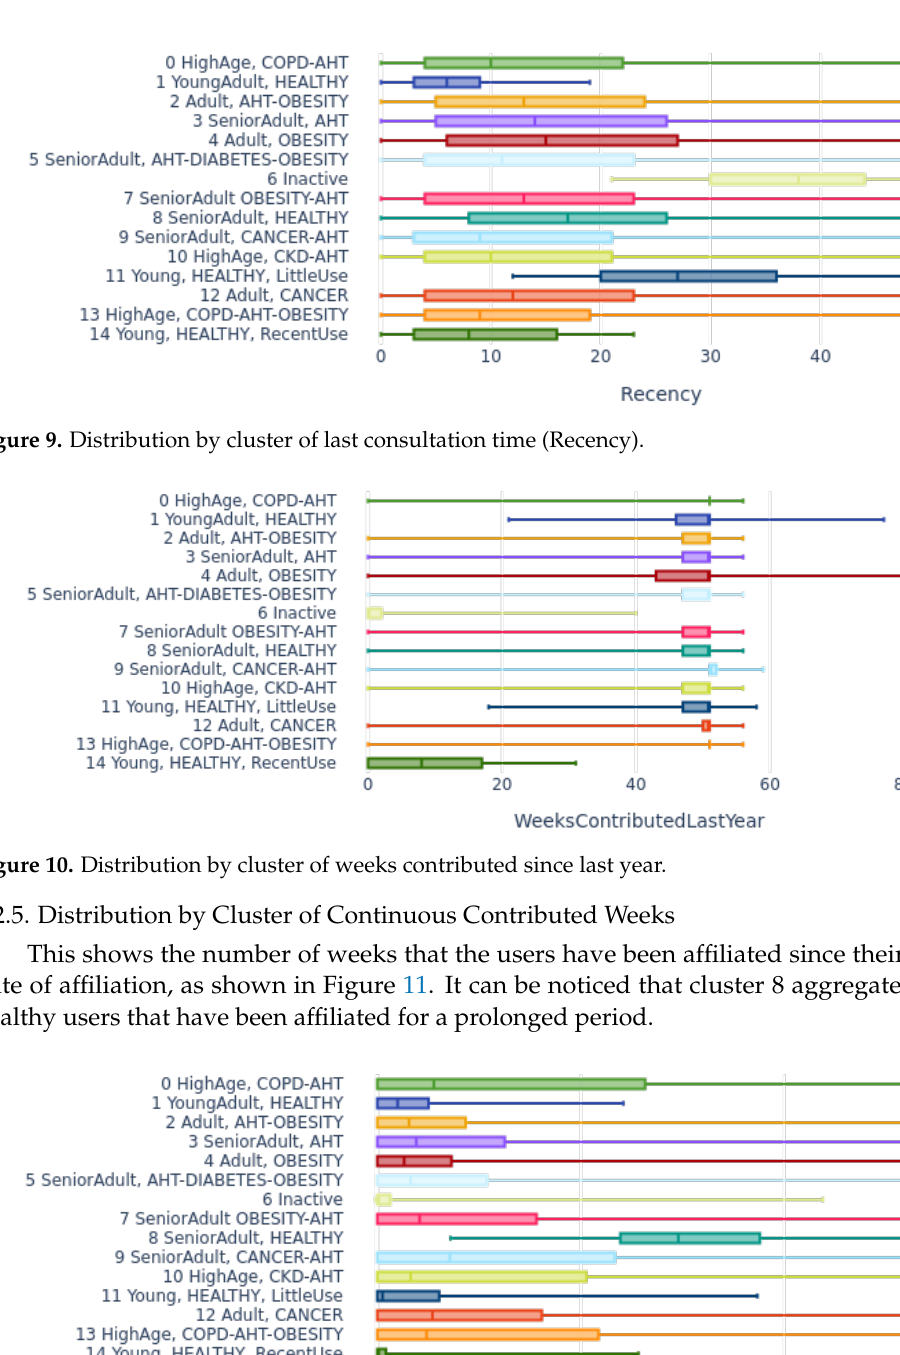
Table 9. Result for clusters with different RSMEs.